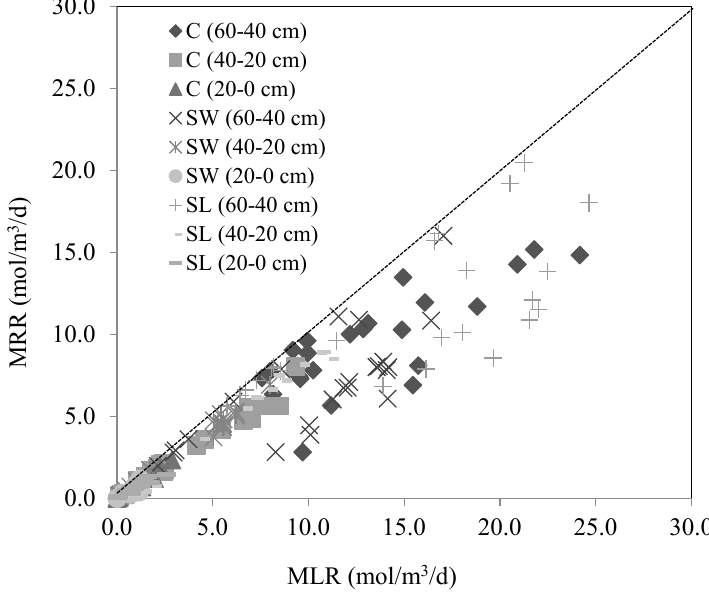
Figure 3. Relationship between methane loading and removal rates in bio-cover materials.